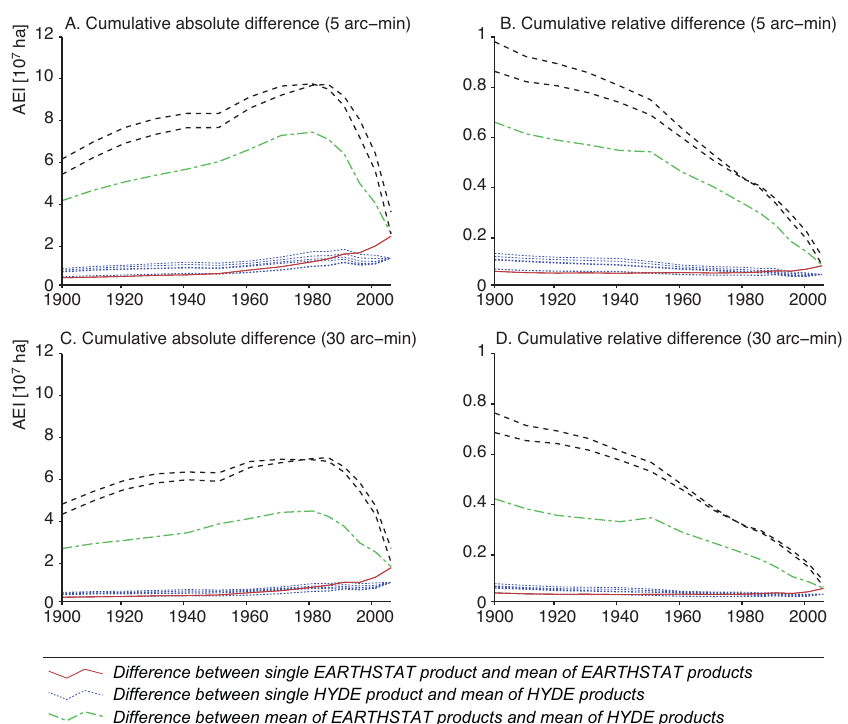
Figure B2. Cumulative absolute differences (a, c) of area equipped for irrigation (AEI) in hectares (ha) and cumulative difference relative to total AEI (b, d) calculated at 5arcmin resolution (a, b) and at 30arcmin resolution (c, d) between single products and the mean of the EARTHSTAT and HYDE products, between mean of the EARTHSTAT and HYDE products and between the newly developed gridded products and AEI according to the national scaling